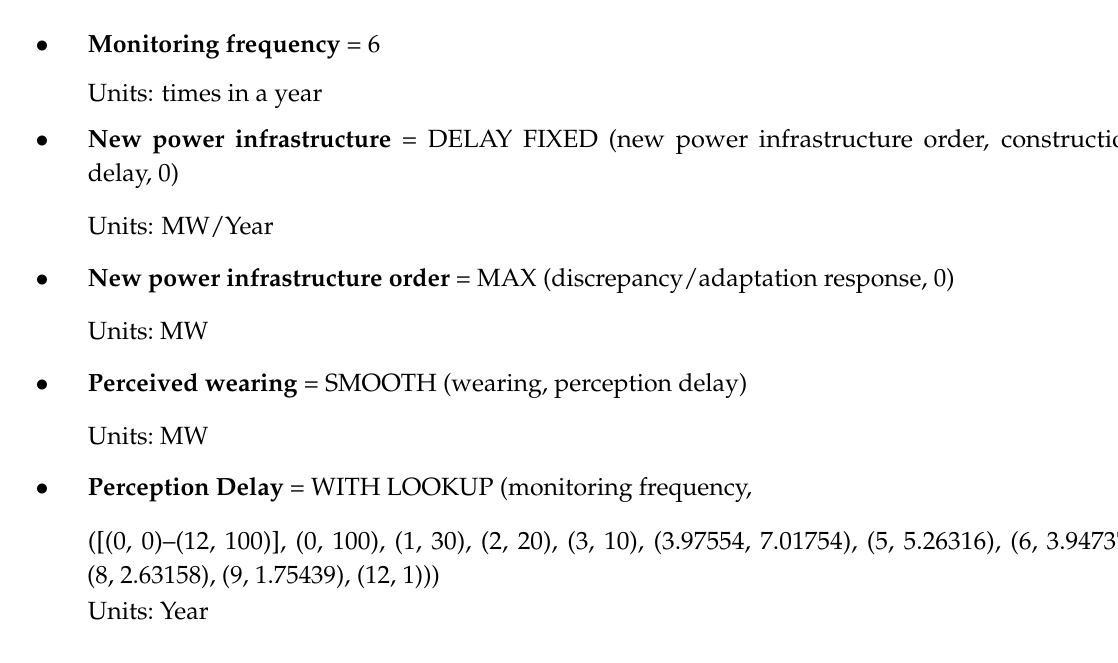
Figure A2. The relationship between learning score ( y axis) and experience ( x axis).